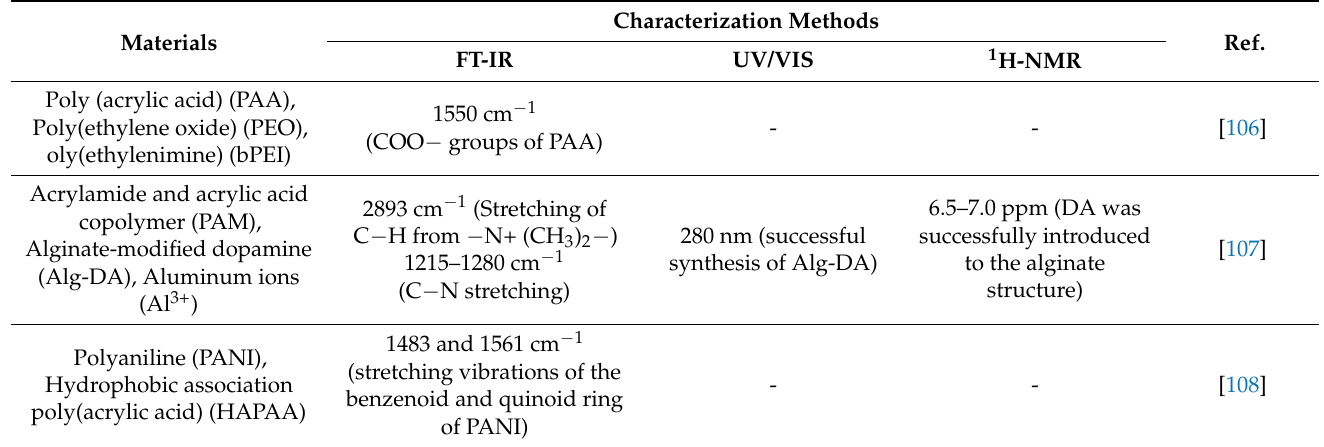
Table 5. Overview of characterization methods for electrostatic interaction.